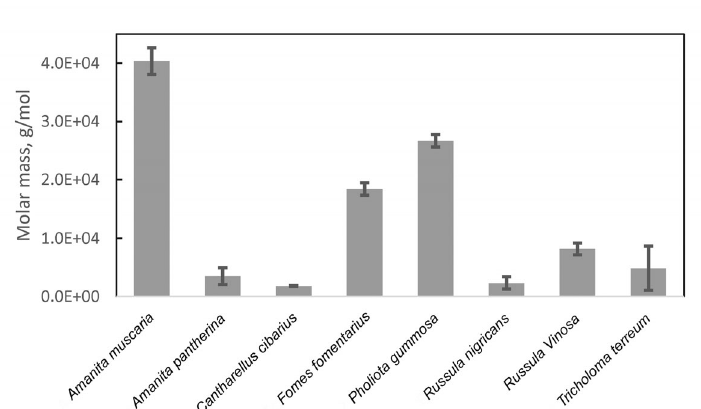
Fig. 2. Viscosity average molar mass of extracted